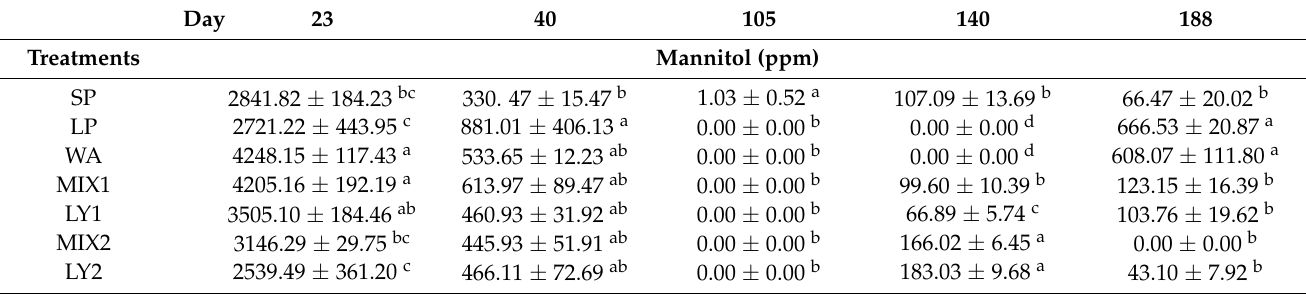
Table 3. Change in concentration of alcohols in the pulp of Leccino olives during spontaneous (SP) or starter-driven fermentation, measured by HPLC analysis. Different letters indicate significant differences among the different treatments ( p ≤ 0.05) at the same sampling time. Data are average from three replicates ± standard